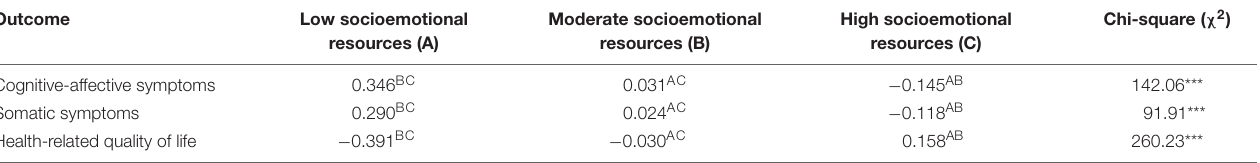
TABLE 3 | Three-step results for distal outcomes (BCH).